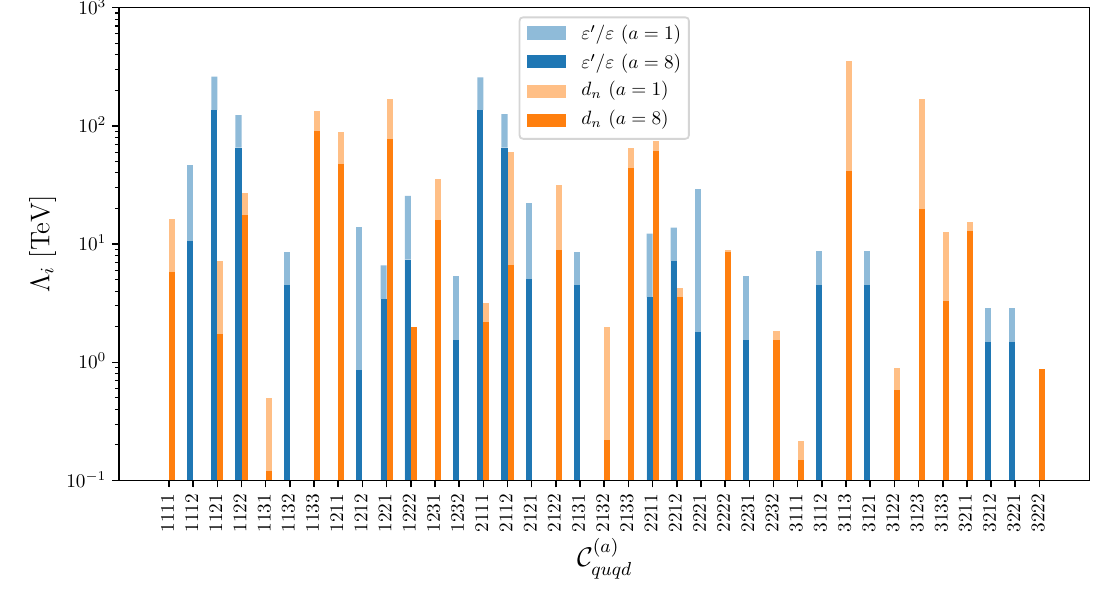
Fig. 3 Effective scales (cid:8) i for the neutron EDM [orange] and the NP contribution to ε (cid:2) /ε [blue], parametrized as in (39) and (41), respec- tively. Only non-redundant index combinations are shown. Coefficients